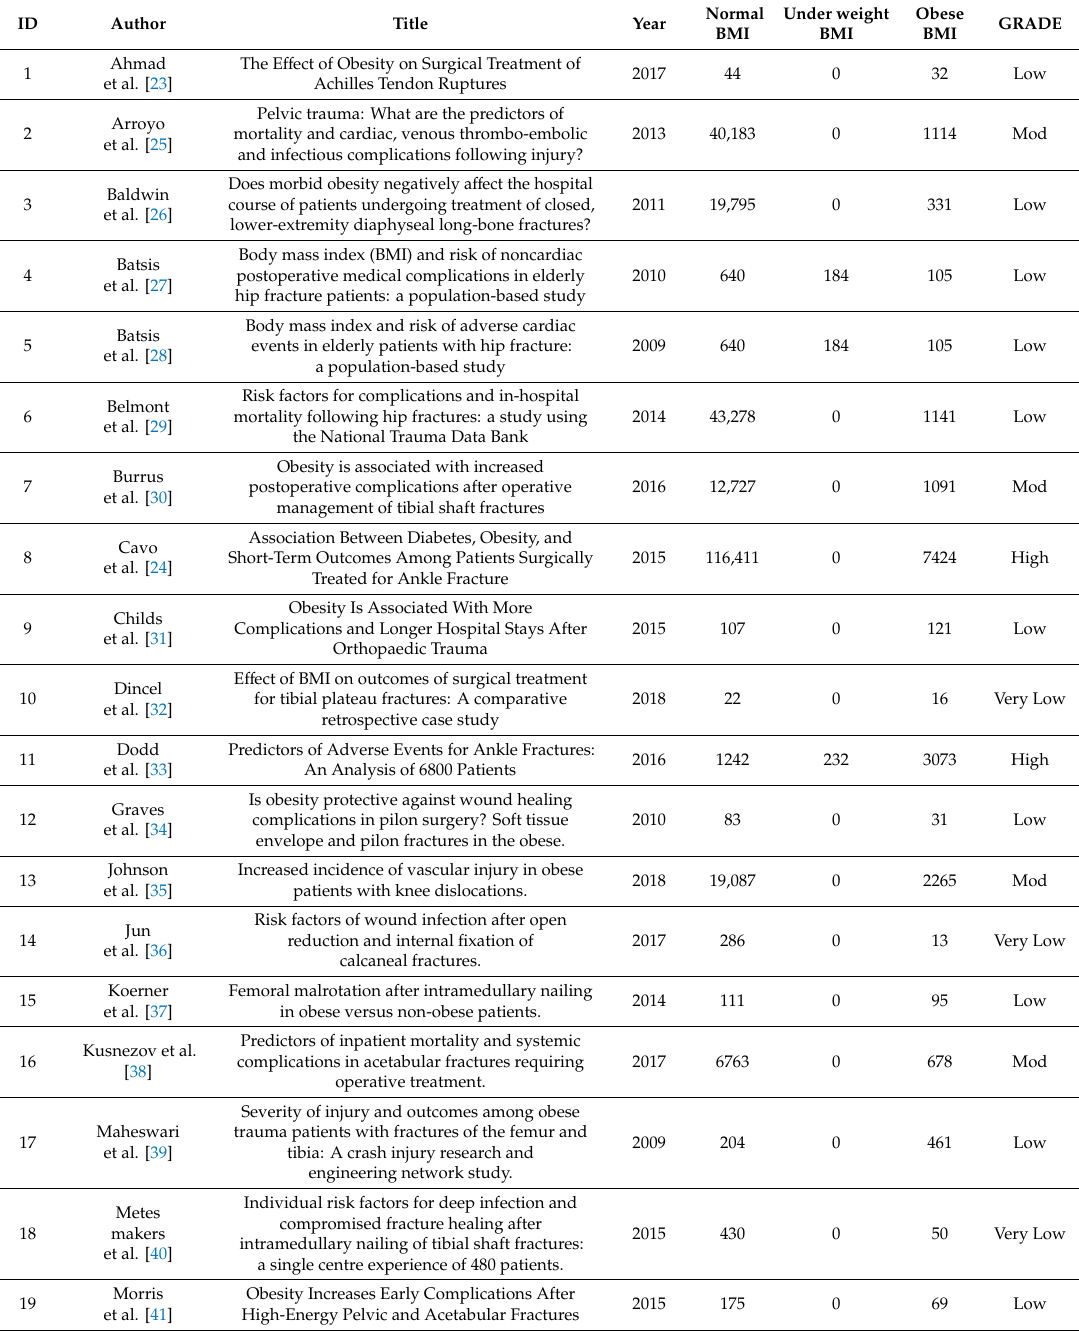
Table 1. Outline of article included in the review and respective patient